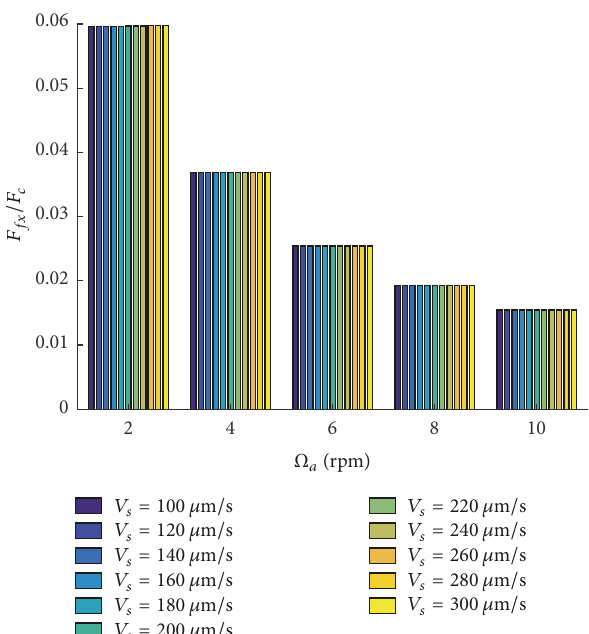
Figure7:InfluenceoftheStribeckvelocityonthechangeinfriction.